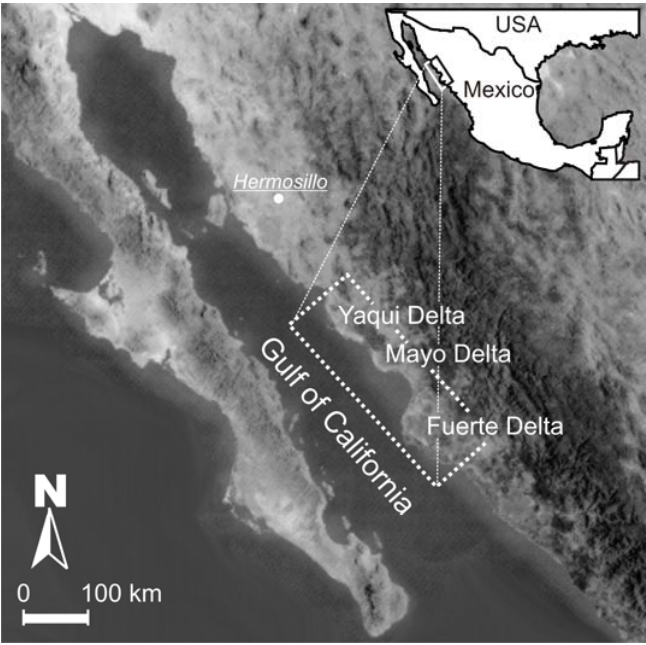
Figure 1. Location of the study area (a composite of four Landsat scenes). Inset: location of mangrove communities in the Gulf of